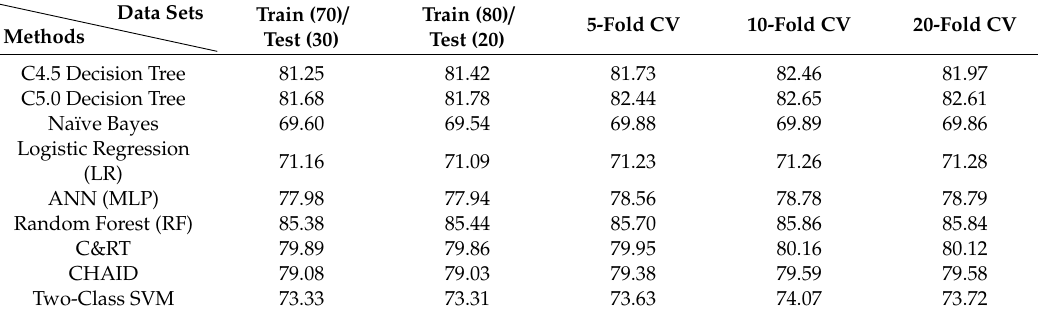
Table 3. Prediction accuracy of stroke after quartile application (%).